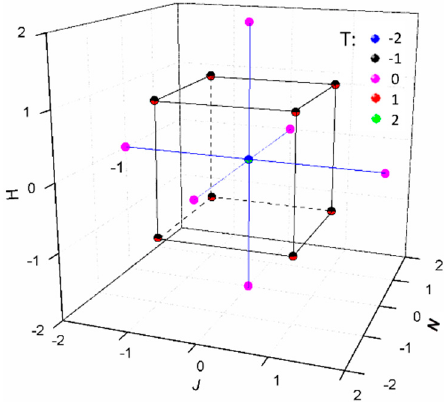
Figure 2. Distribution of sampling points for four-factor central-composite design.